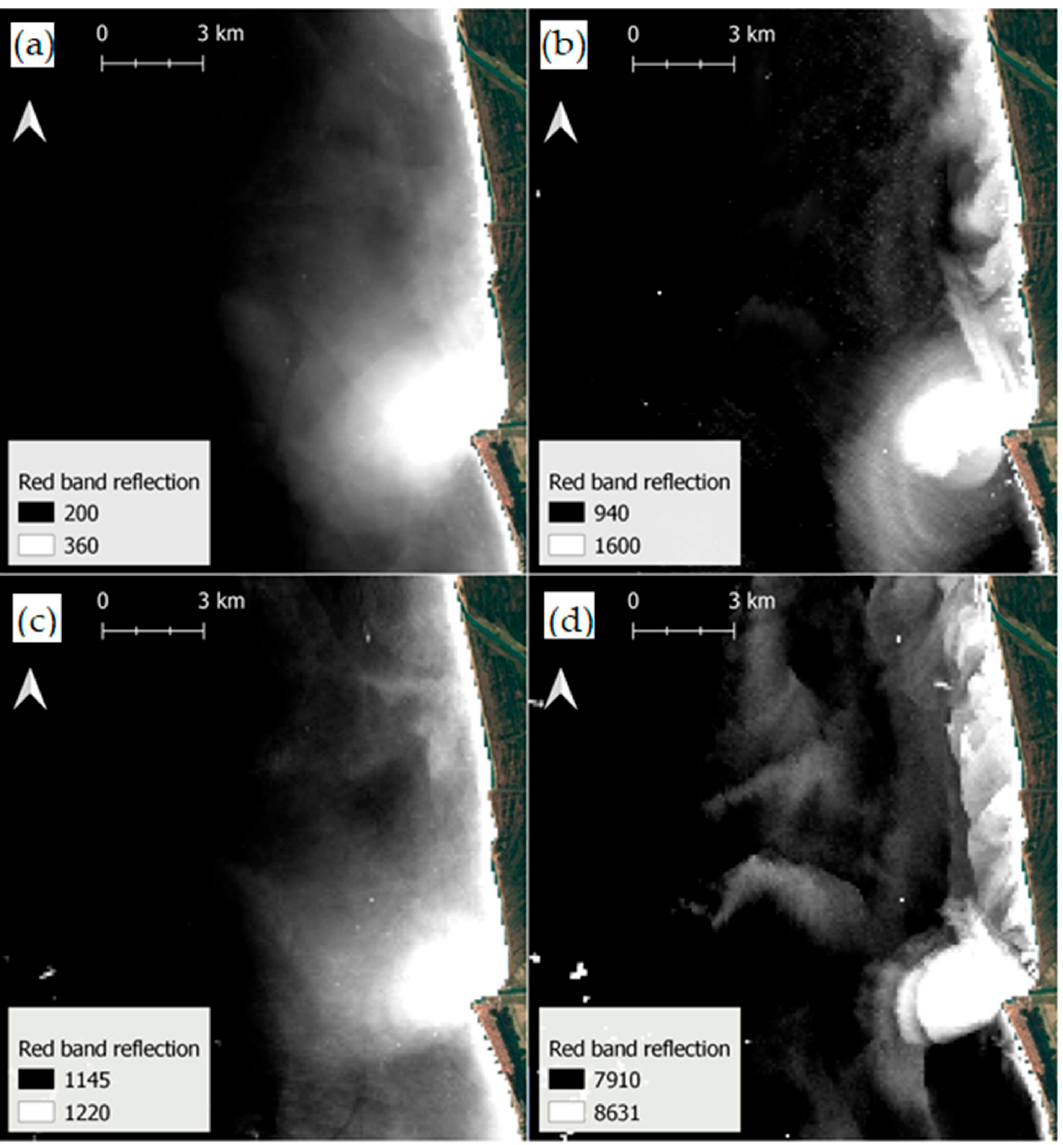
Figure 8. Analyses of the red band of 50 Sentinel-2 images and 101 Landsat images, acquired during the period 1984–2020. In each pixel the mean value recorded in the Sentinel-2 images ( a ) and Landsat images ( c ) respectively, are shown. In each pixel the maximum value recorded in the Sentinel-2 images ( b ) and Landsat Images ( d ), respectively, are shown.